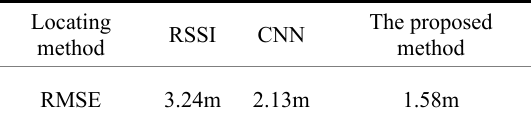
Table 3 . Results of different positioning